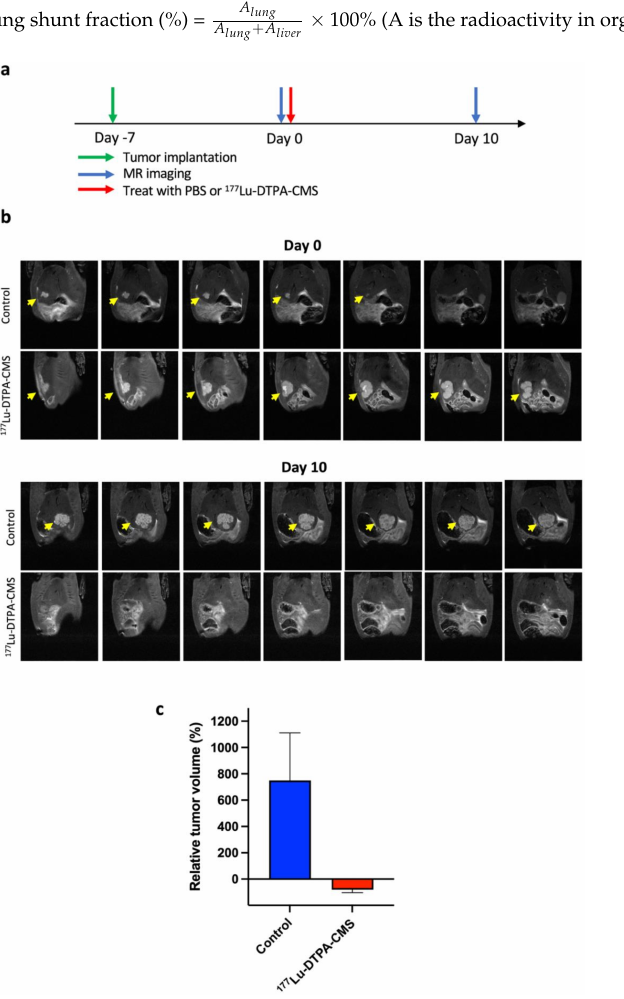
Figure 5. The therapeutic efficacy of 177 Lu-DTPA-CMS against N1-S1 hepatoma. ( a ) The experimental scheme for the treatment. ( b ) T2-weighted MR imaging of rats treated with 177 Lu-DTPA-CMS or normal saline; yellow arrows represent the tumor. ( c ) Quantification of changes in tumor size ( n =